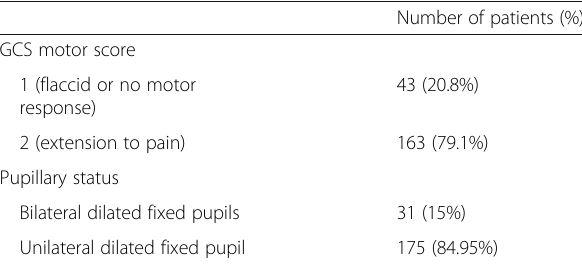
Table 1 The Glasgow Coma Scale (GCS) motor score and the pupillary status after resuscitation